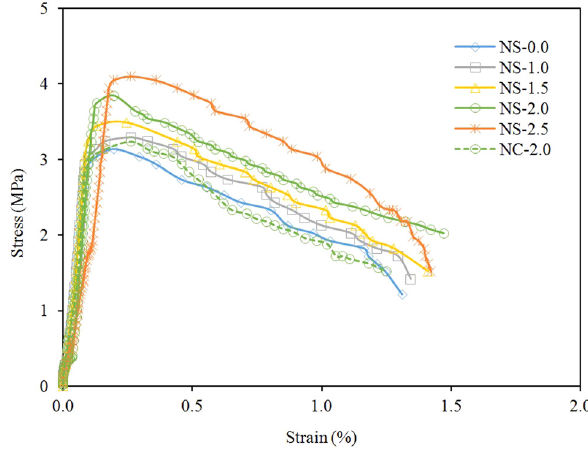
Figure 6: E ff ect of NS content on tensile stress – strain